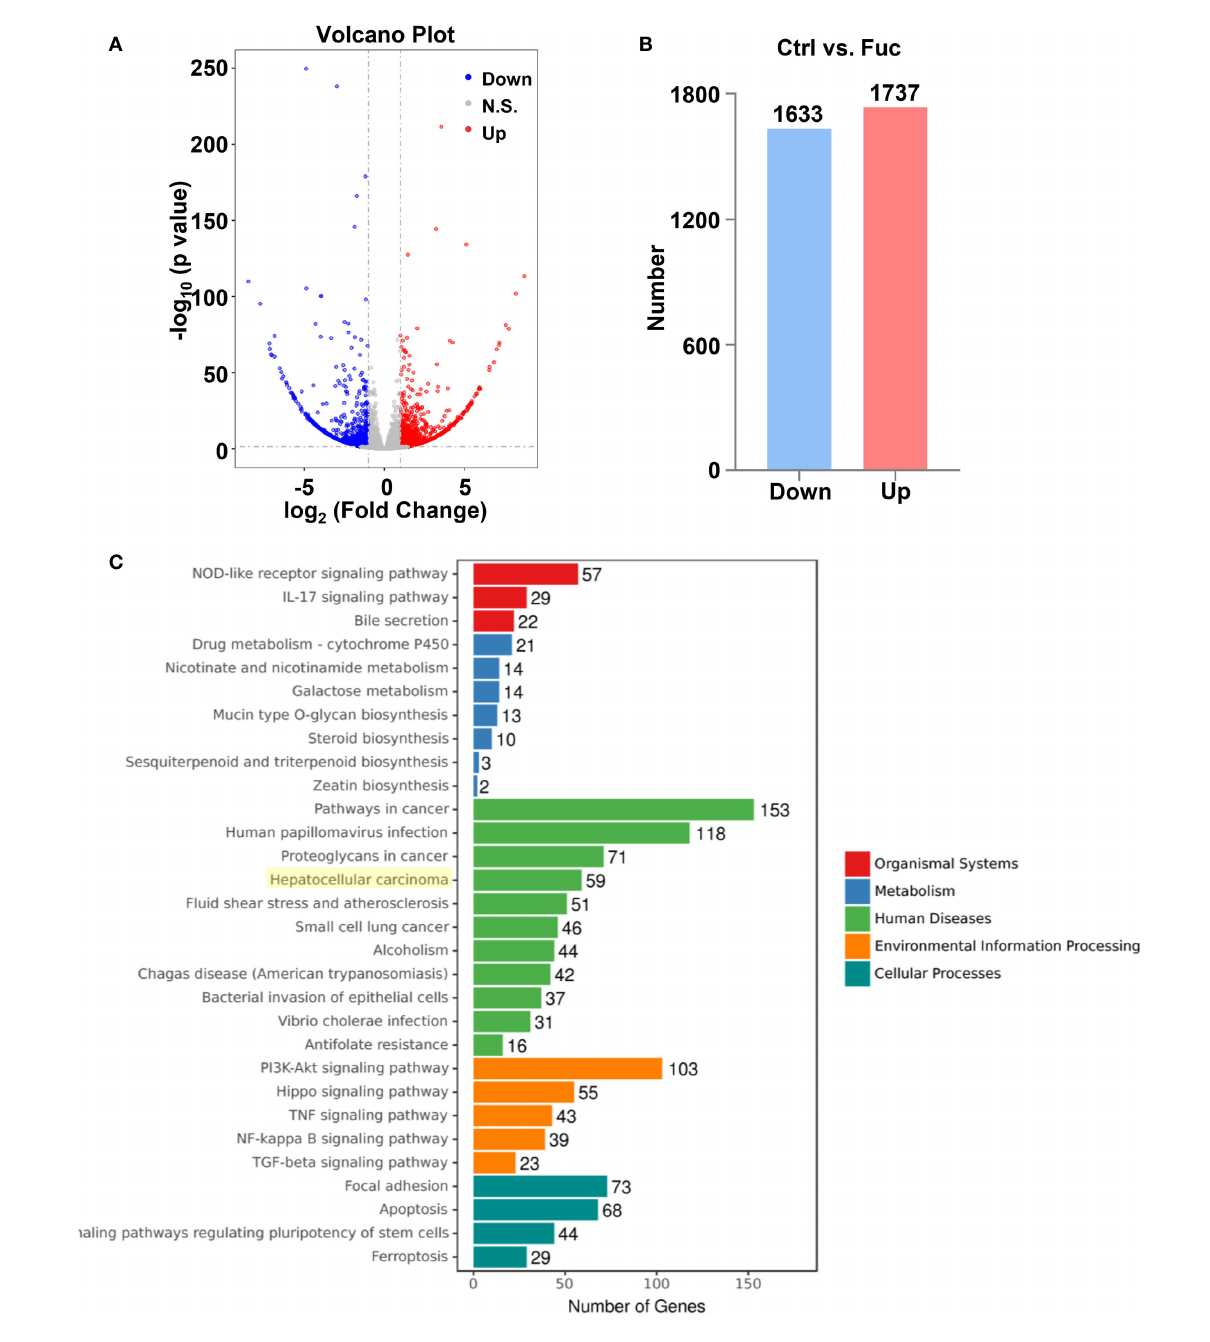
FIGURE 6 | The alteration of mRNAs pro fi ling regulated by fucoidan in MHCC-97H cells. (A) Volcano plots presents signi fi cantly different expression pro fi les of mRNAs in MHCC-97H cells treated with 0.5 mg/mL Fuc. (B) Numbers of signi fi cantly down and up-regulated mRNAs in MHCC-97H cells treated with 0.5 mg/mL Fuc. (C) Enriched KEGG pathways of differentially expressed mRNAs after fucoidan treatment. p value <